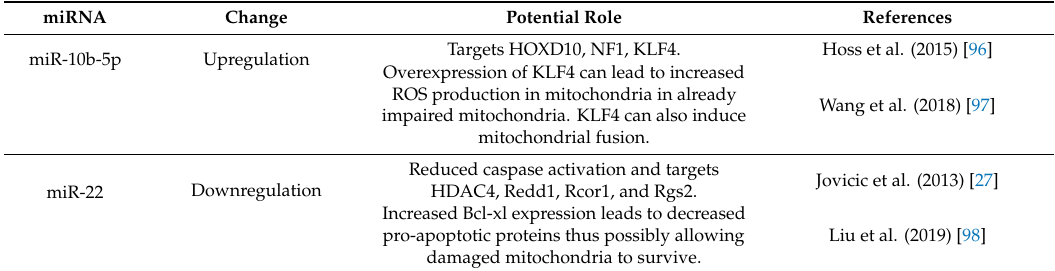
Table 3. MicroRNAs and their role in Huntington’s